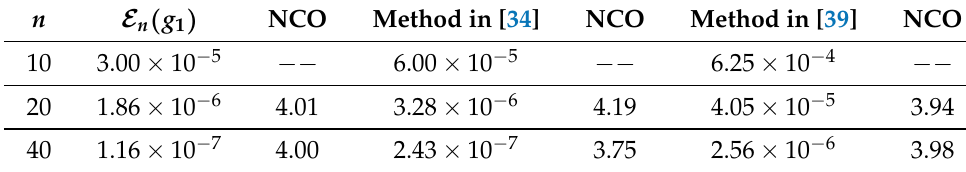
Table 2. Estimated errors for function g 1 , and NCOs with different values of n